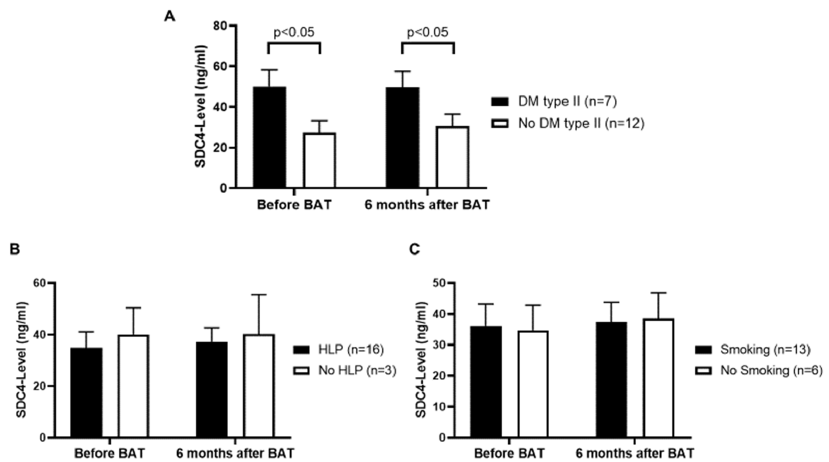
Figure 2. ( A ): Patients who do not su ff er from diabetes mellitus (DM) type II show lower levels of serum SDC4 as compared to patients with concomitant DM type II. ( B ): HLP does not show an association with serum SDC4-levels. ( C ): Smoking does not alter serum SDC4-levels. Values are given as means ± SEM.